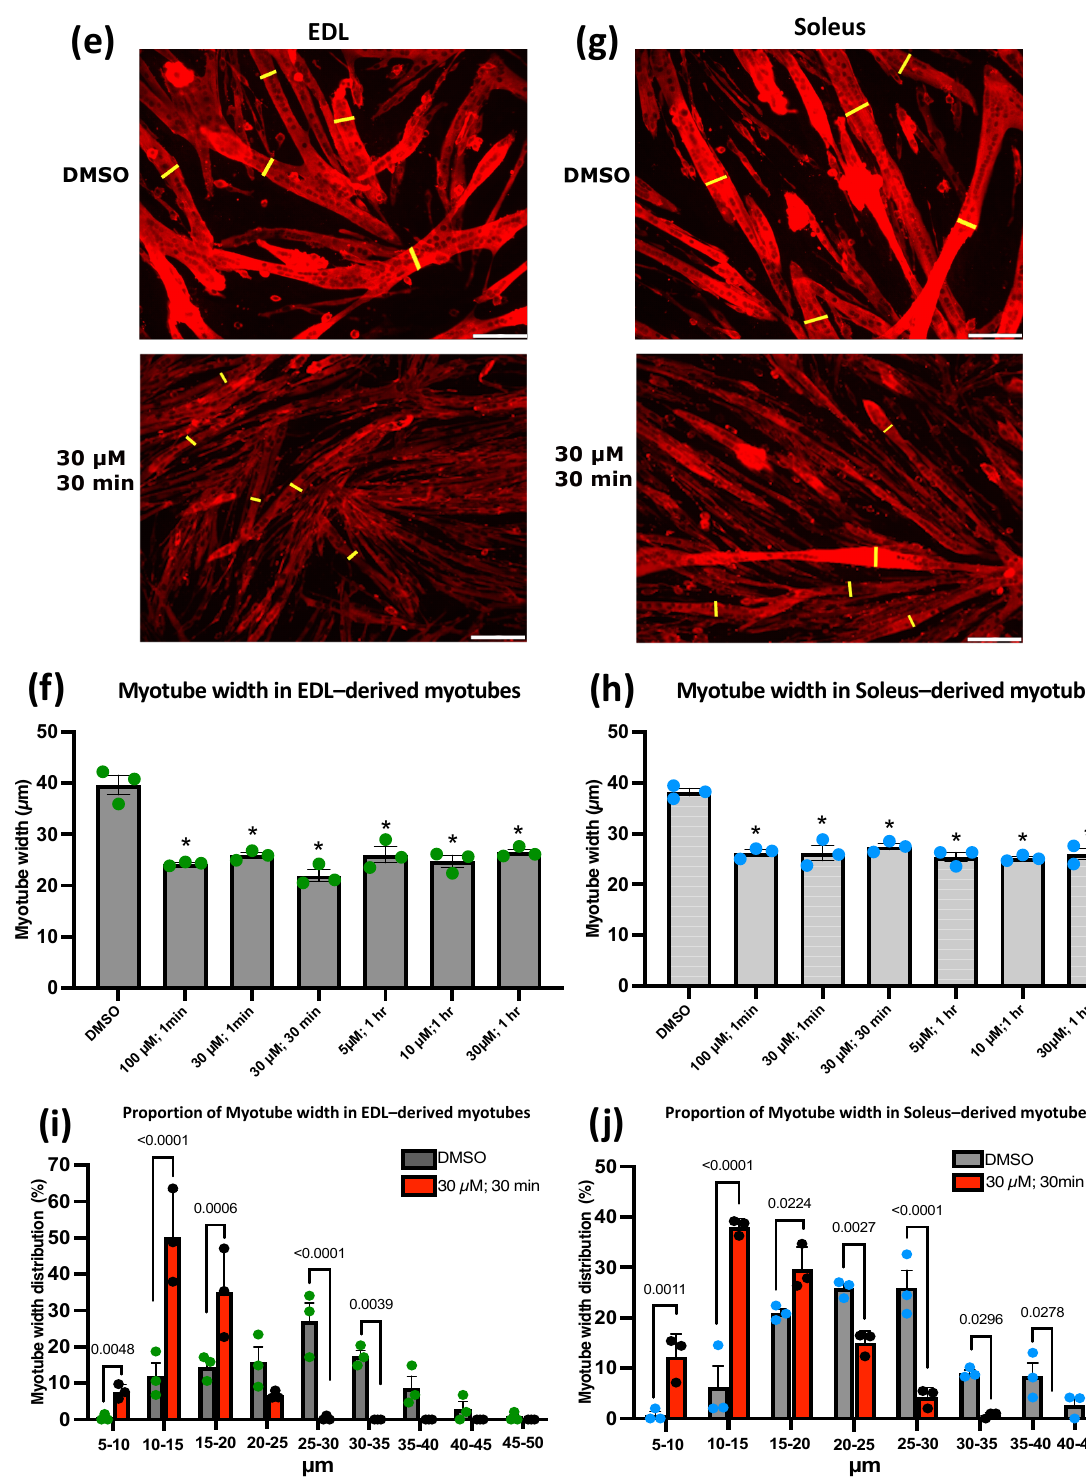
Figure 4. Piezo1 activation increases myoblast fusion at the expense of myotube syncytial matura- tion. ( a , c ) Representative images of cohorts at relevant timepoints and concentrations, immunostained for myosin heavy (MyHC) (red panels) and counterstained with DAPI (black and white panels). Micrographs taken at × 20 magnification. Scale bar is 100 µ m. ( b , d ) Bar graphs displaying fusion